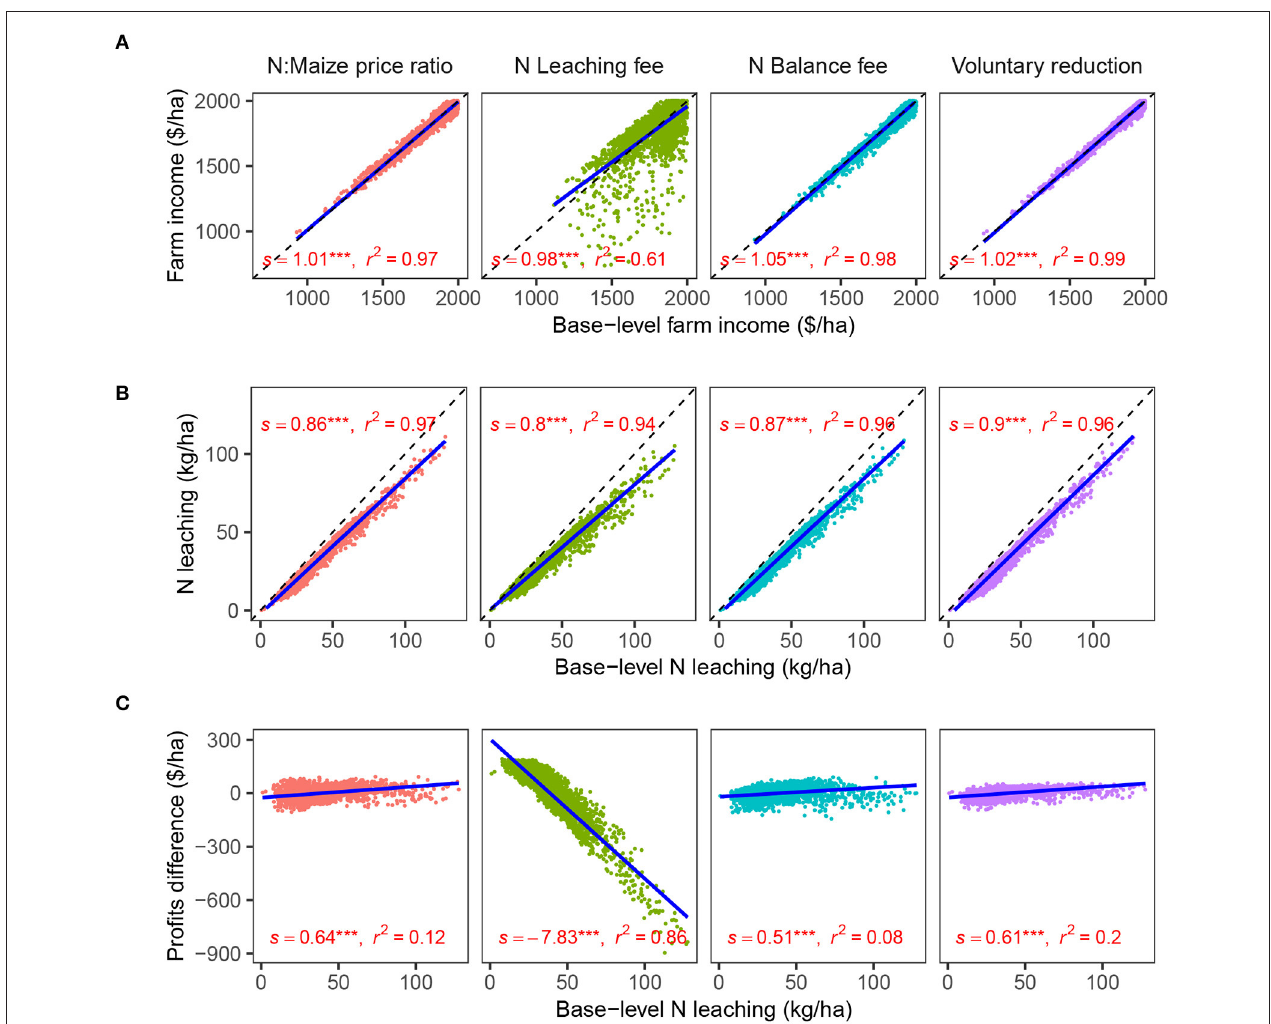
FIGURE 4 | Field-level effects for the different policies compared to base-level indicators: (A) Farm income (farm profits + compensation) relative to the base-level income (income effect). (B) N leaching relative to the base-level N leaching (point source reduction effect). (C) Profits difference (farm profits after policy—farm profits before policy) relative to the base-level leaching (internalization effect). Observations are at the field level, averaged across years. Linear regressions were fitted independently to each set of data, and report the estimate of the slope (s), test of significance (ns = non-significant; *= p < 0.1, **= p < 0.05; ***= p < 0.01), and coefficient of determination ( r 2